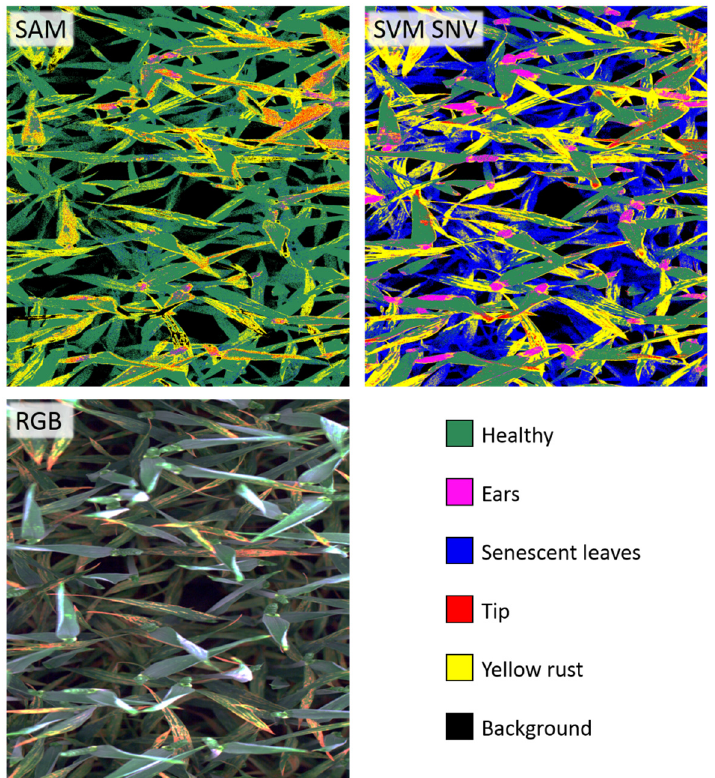
Figure 5. Visual comparison of the representative spectral angle mapper (SAM) classification ( top left ) and the support vector machine standard normal variate (SVM SNV) classification ( top right ) with the original RGB visualization of the corresponding ground-based image of one representative measurement location of a plot inoculated with YR ( bottom left ). The image is captured with the hyperspectral camera Specim V10. The classes ( bottom right ) were generated from manual annotation of train and test data.